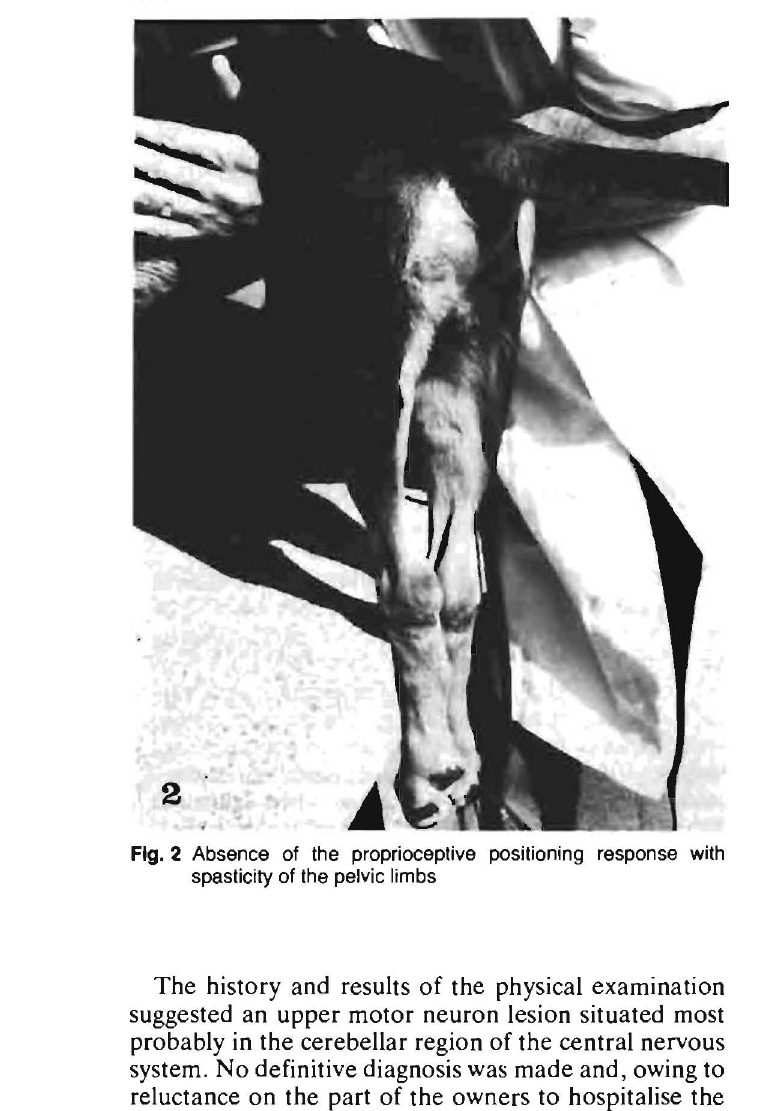
Fig. 2 Absence of the proprioceptive positioning response with spasticity of the pelvic limbs